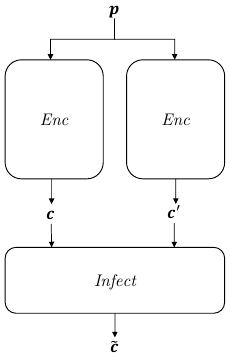
Figure 1: Infective Computation Scheme such as that of [LRT12]